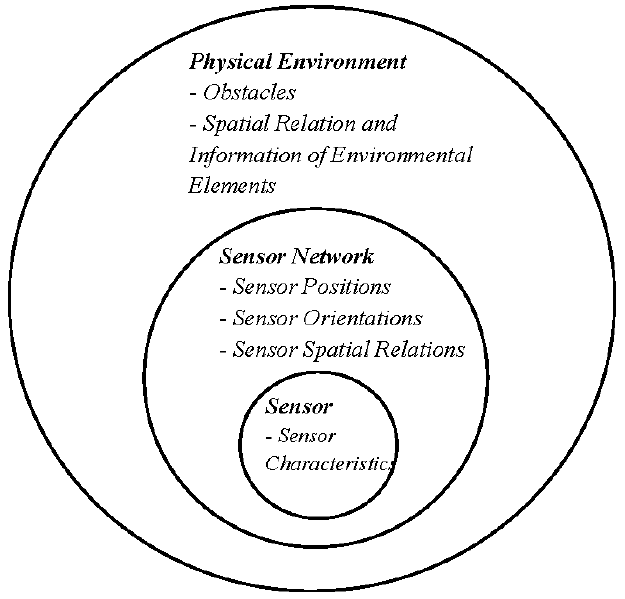
Figure 1. Three components of context in sensor network